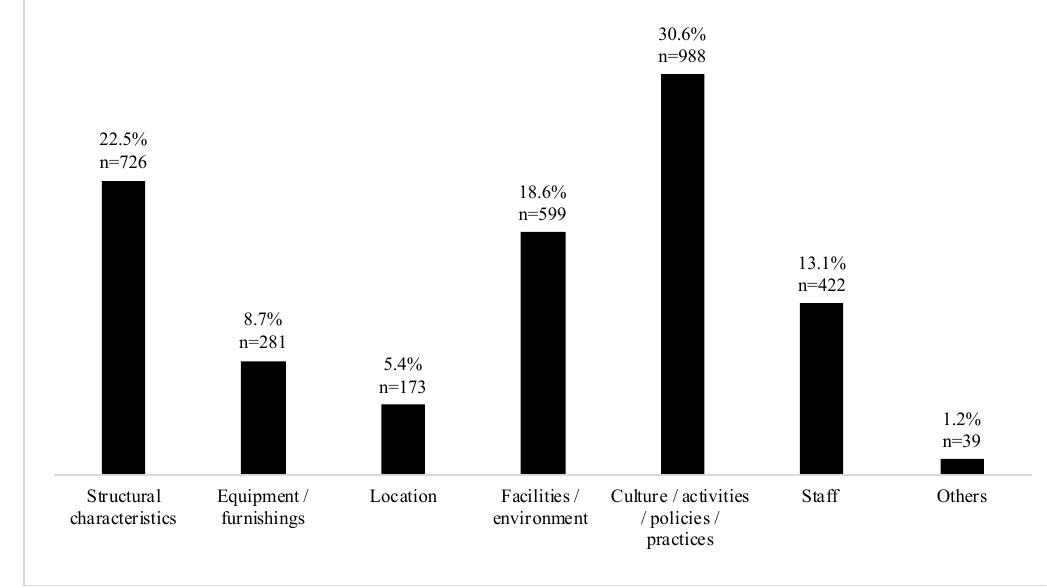
Figure 2. Frequency of ECEC center characteristics examined in the scoping review (%, n ).